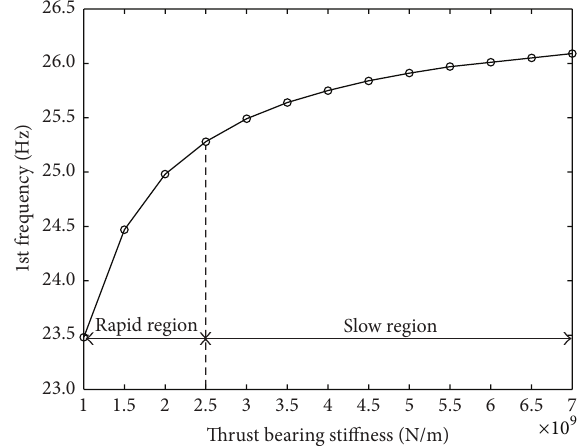
Figure 11: Effect of thrust bearing stiffness on the 1st natural fre-